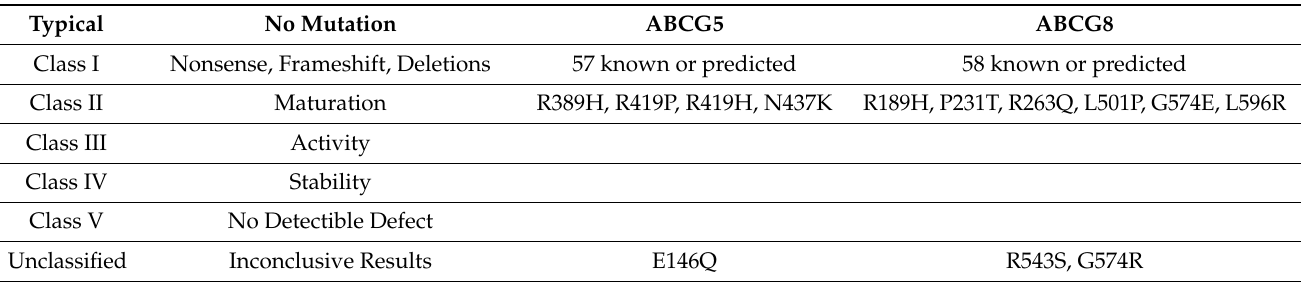
Table 1. Classification system for experimentally verified sitosterolemia